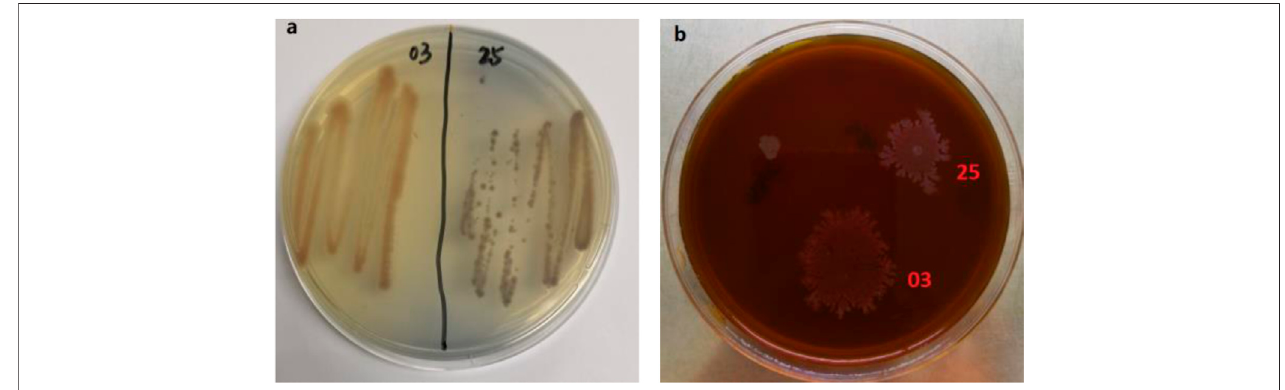
FIGURE 1 | Screened strains on the Azure-B and lignin plates. (A) Azure-B plates, with 0.01% azure-B added; (B) alkali lignin plates with alkali lignin as the sole carbon source (2 g/L).